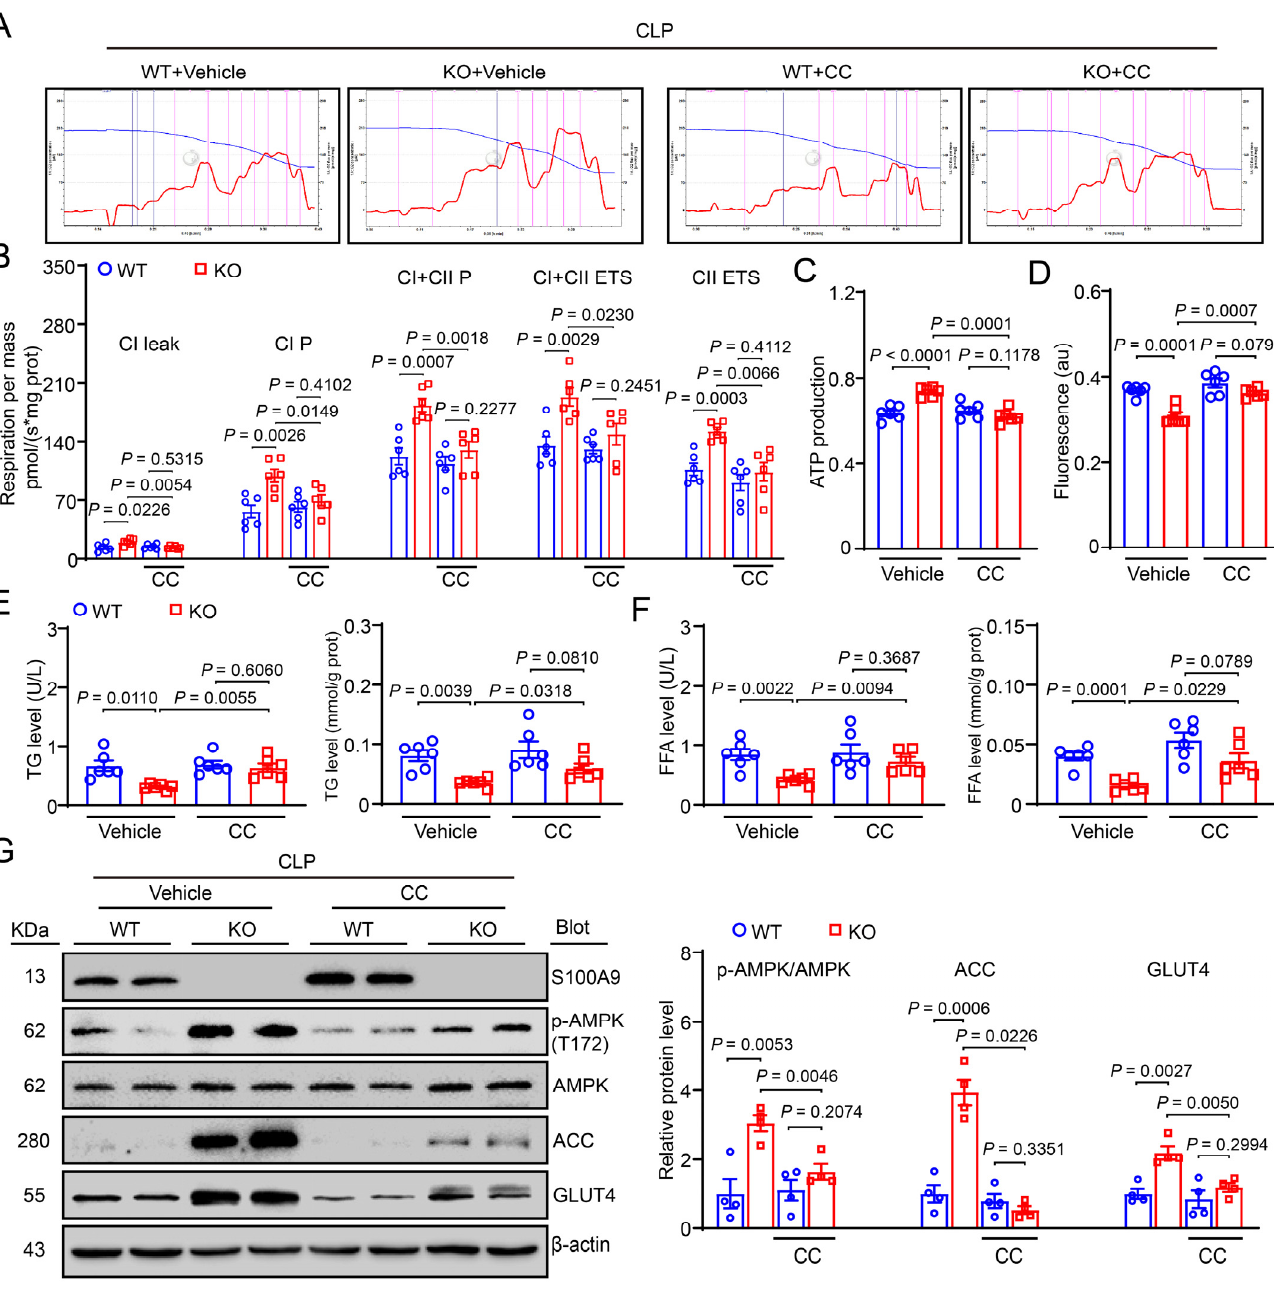
Figure 5. Blocking AMPK abrogates the S100A9-KO-mediated improvement of CLP-induced liver mitochondria dysfunction and reduction of glucose and lipid metabolism. ( A ) Representative images of O 2 concentration change (blue line) and O 2 flux per mass (red line) in groups. ( B ) Summarized data for the oxygen consumption capacity measured by high-resolution respirometry in CI leak, CI P, CI + CII P, CI + CII ETS, CII ETS ( n = 6). ( C ) ATP production and ( D ) fluorescence (represent mitochondrial membrane potential) ( n = 6). ( E ) Serum and ( F ) tissue levels of TG and FFA ( n = 6). ( G ) Immunoblotting analysis of S100A9, p-AMPK, AMPK, ACC, GLUT4 (left) and quantification of the relative protein levels (right, n = 4). Data are shown as mean ± SEM, and n represents the number of mice in each group.